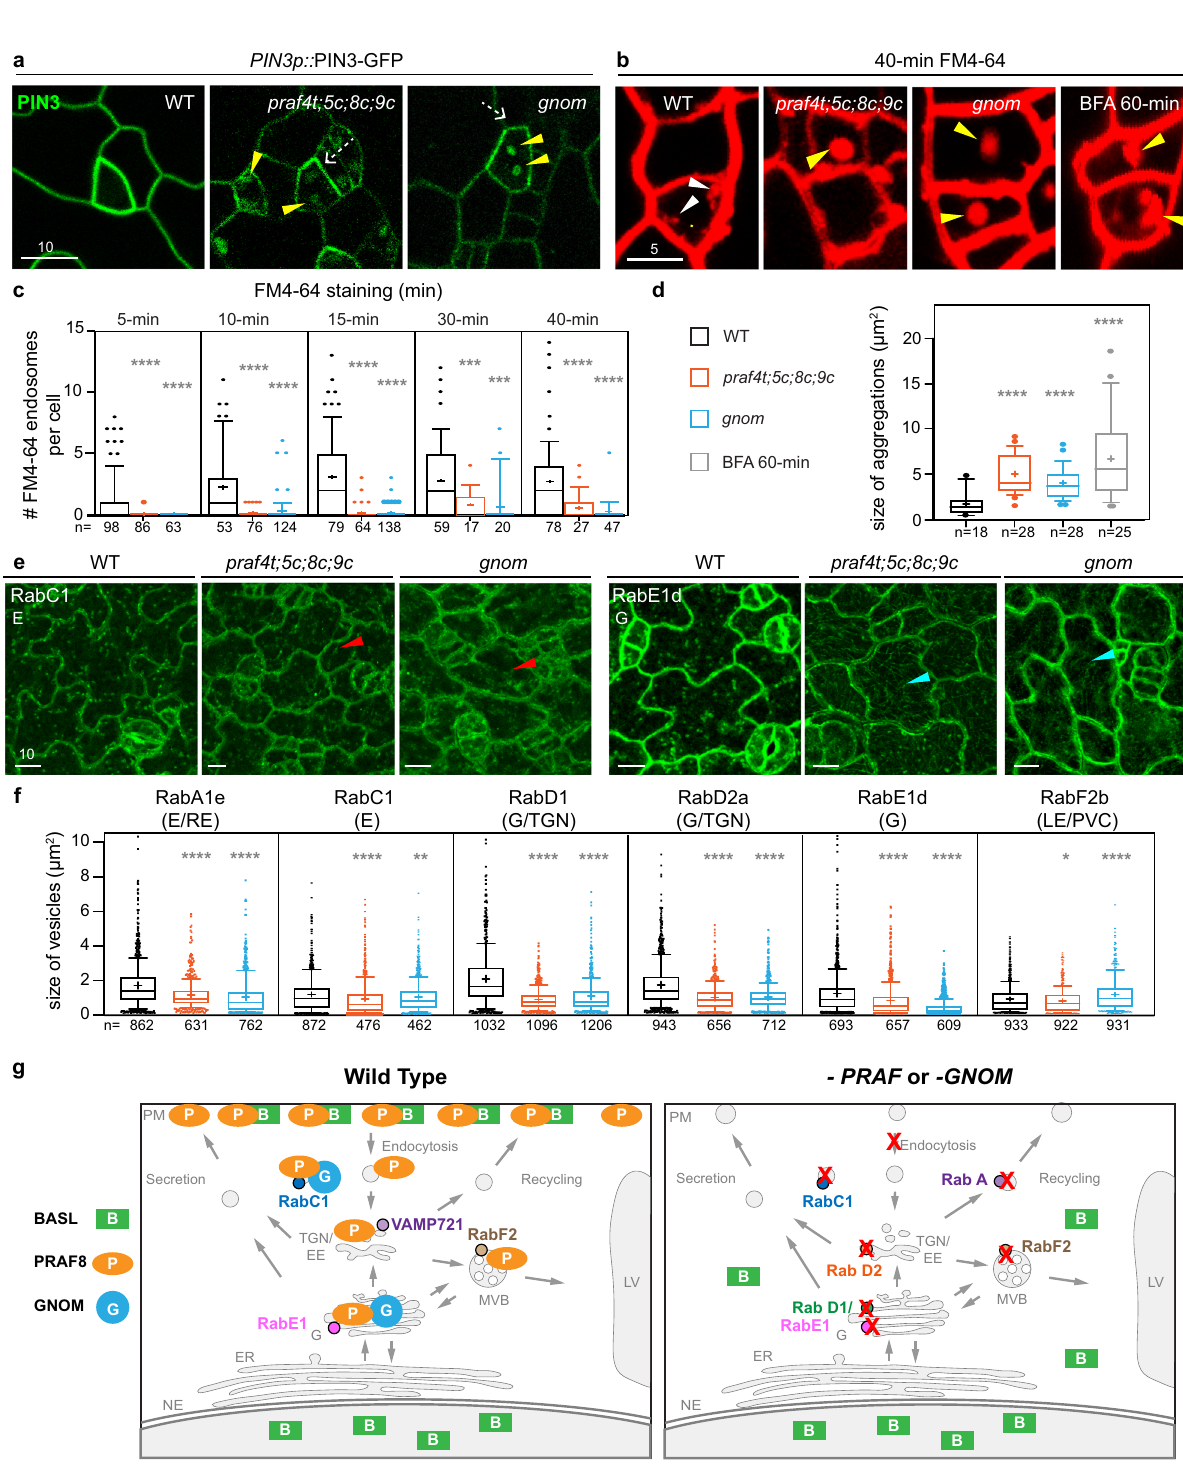
vesicles near the apical surface in polarized epithelial cells to promote targeted secretion 48,70 . The plant RabE GTPases, homologs of Sec4/Rab8 (yeast/mammals) 48 , were found to loca- in both Arabidopsis and tobacco 49,50,71 – 73 . Thus, we propose that the connected function of PRAF-GNOM may regulate Golgi and post-Golgi endosomal activities, particularly the RabC- and RabE-mediated pathways, to promote directional exocytosis and secretion (Fig. 7g). This hypothesis is supported by the previous observation of cell wall defects in gnom mutants 74 and our